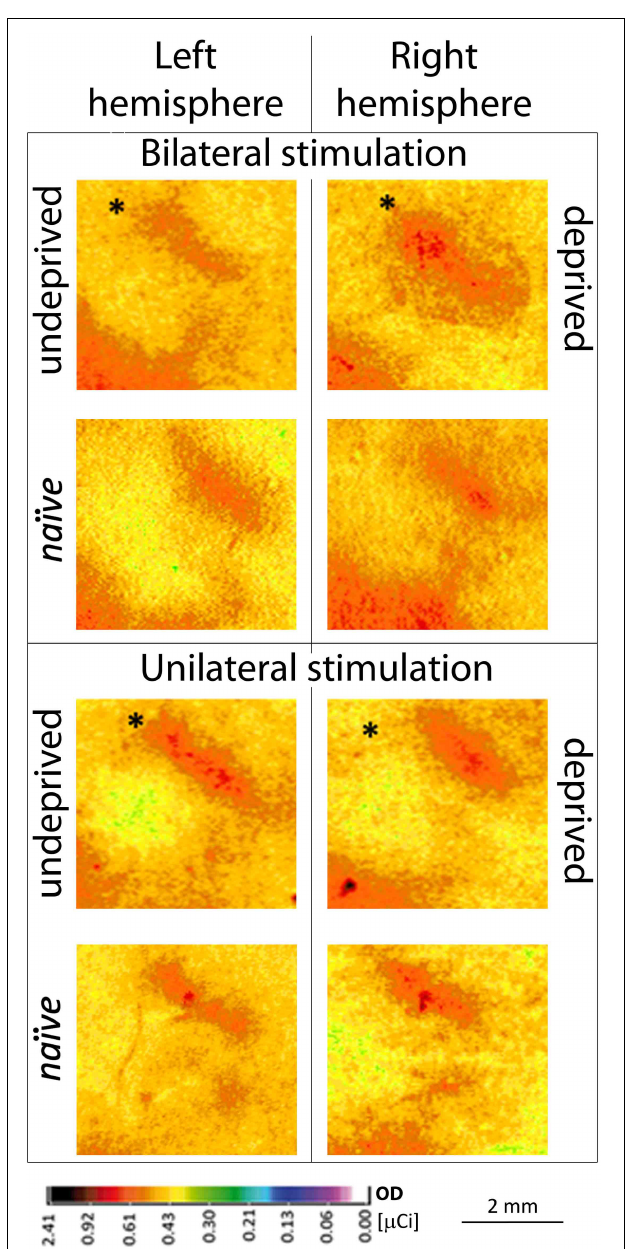
FIGURE 2 | Contralateral 2DG incorporation of row B representations in the two hemispheres during uni- vs. bilateral whiskers stimulation in deprived experimental groups. Individuals with unilateral, partial whiskers cut and bilateral stimulation ( n = 8) or individuals with unilateral stimulation ( n = 6) of whiskers’ row B during brain activity mapping are shown; bottom row: naïve animal; ∗ Mean ± SD; ∗ P < 0.05.